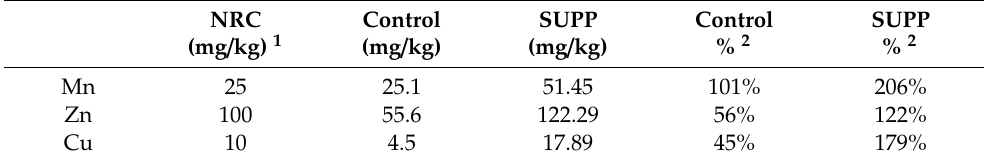
Table 2. Mineral inclusion rates in the diets of control (fed to all pigs) and supplemented (SUPP;